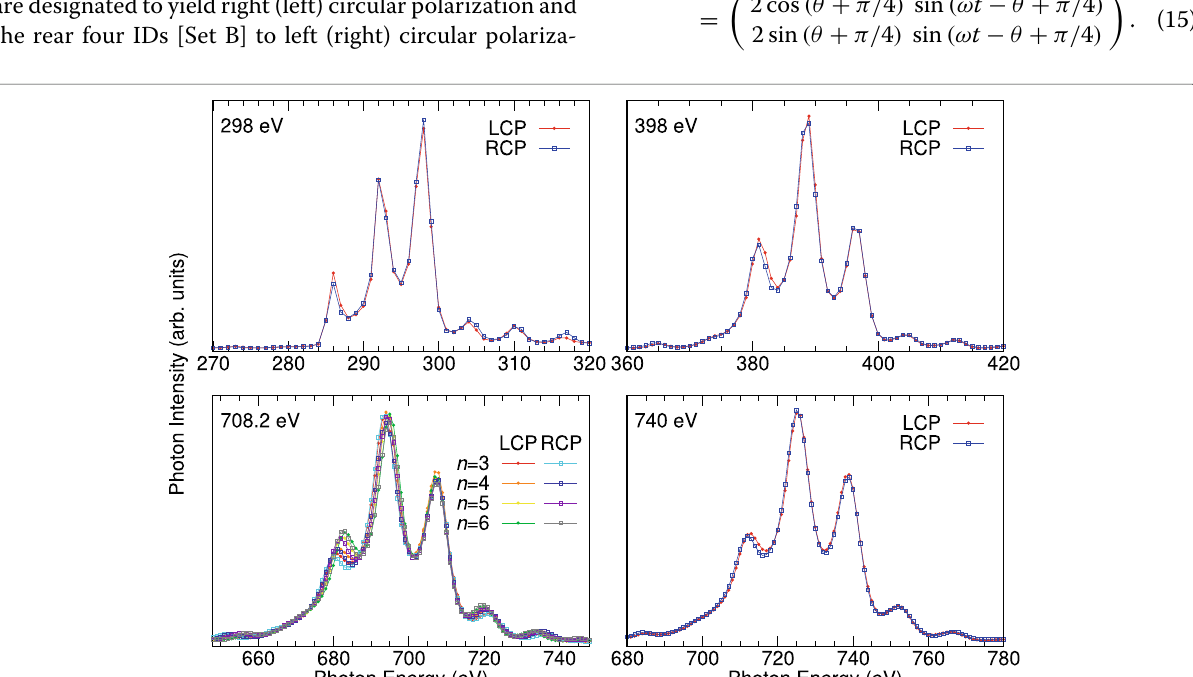
Fig. 17 Energy spectra in CP mode for different energies. At (cid:2) ω =708.2 eV, energy spectra for different n c are also